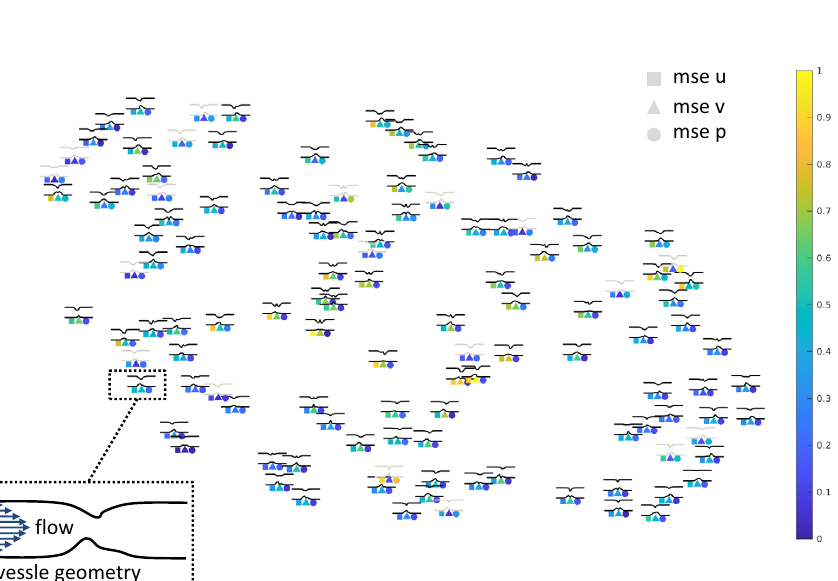
Fig. 6 two dimensional embedding of shape encoded latent vector k by means of t‑SNE technique for visualization. Gray shapes indicating shapes from validation set and black shapes indicating shapes from training set. Under each shape is the mean squared error (mse) with respect to CFD‑Simulations plotted (squares: mse u, triangle: mse v and circles: mse p). The color is linearly scaled between 0 and 1, the corresponding maximal values are mse max u 0.15, mse max v 0.07 and mse max p = = =